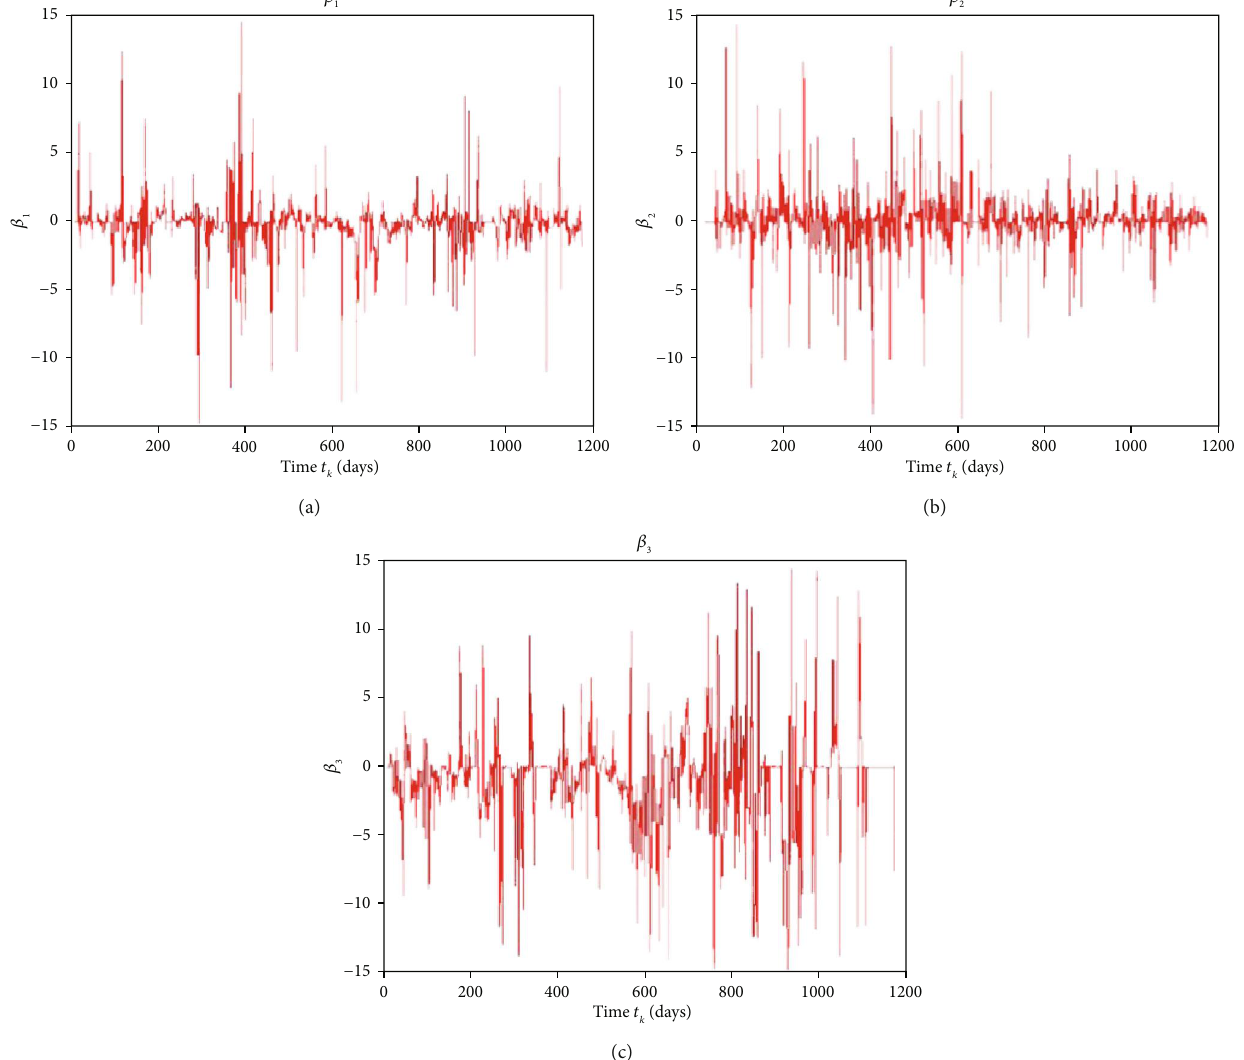
Figure 5: The graph of β